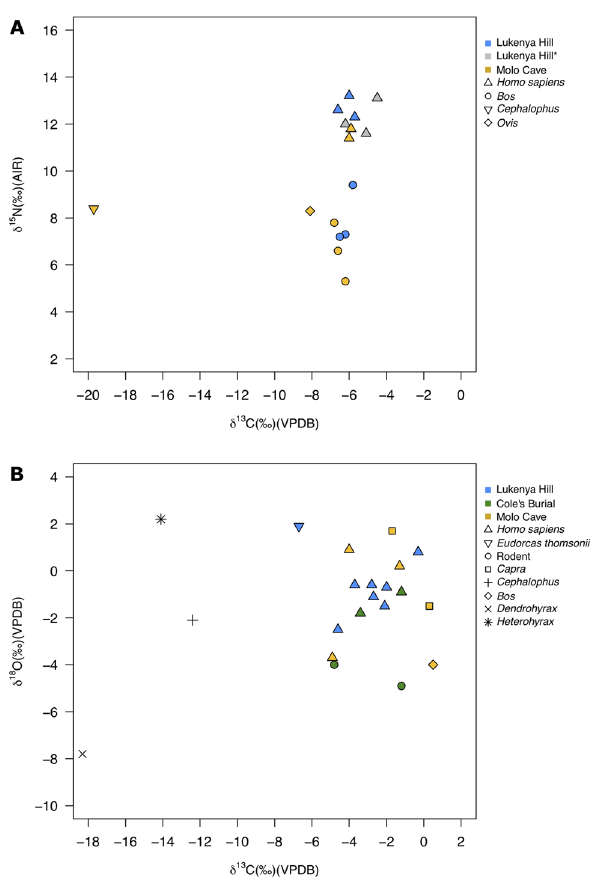
Fig. 4 Stable isotope results for humans and fauna. A Bone collagen stable carbon and nitrogen isotope values for Lukenya Hill and Molo Cave. *Values previously published for Lukenya Hill 53 . B Tooth enamel stable carbon and oxygen isotope values for Lukenya Hill, Cole ’ s Burial and Molo Cave. The Cephalophus , Dendrohyrax , and Heterohyrax were sampled from Lukenya